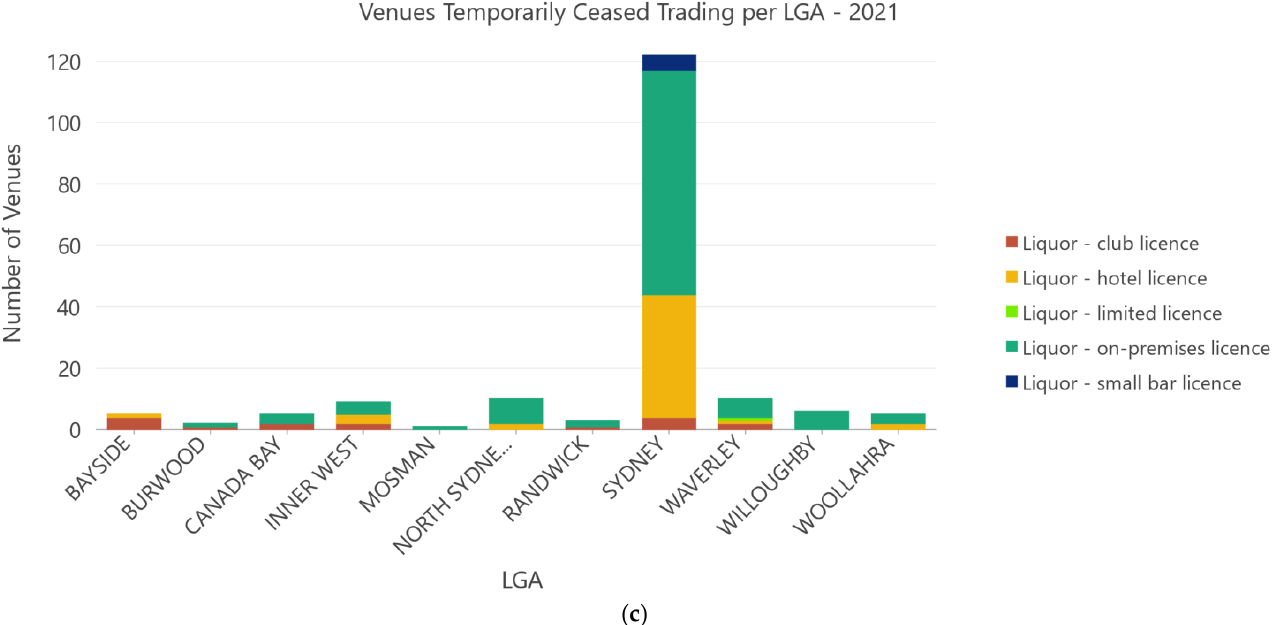
Figure 23. ( a ) Venues listed as having temporarily ceased trading in 2021; ( b ) Hotspot analysis of venues having temporarily ceased trading; ( c ) Number of venues listed as ‘temporarily ceased trading’ by type and LGA 2021.